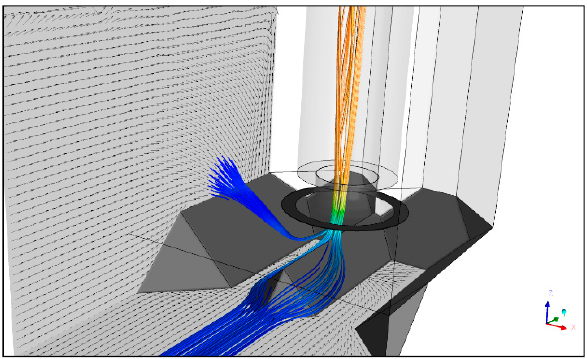
Figure 20. Vector plot showing uniform flow pattern on the sidewalls and sump floor.